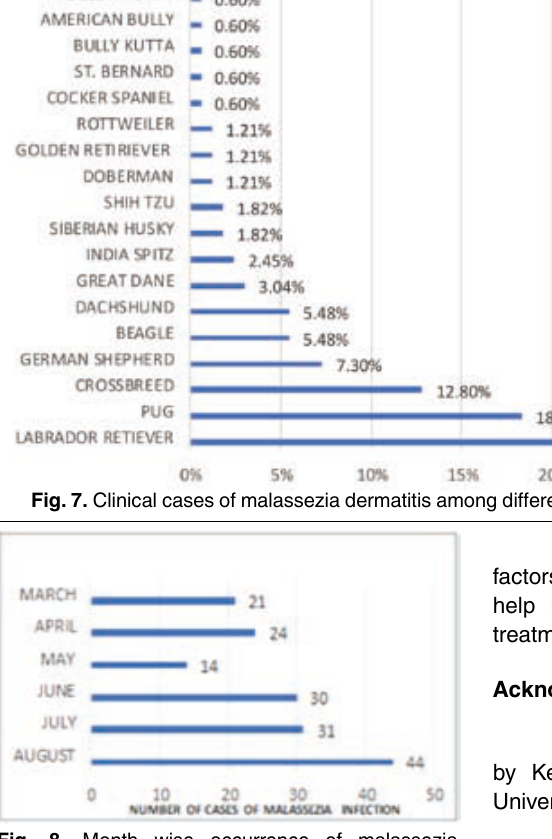
Fig. 8. Month wise occurrence of malassezia infection